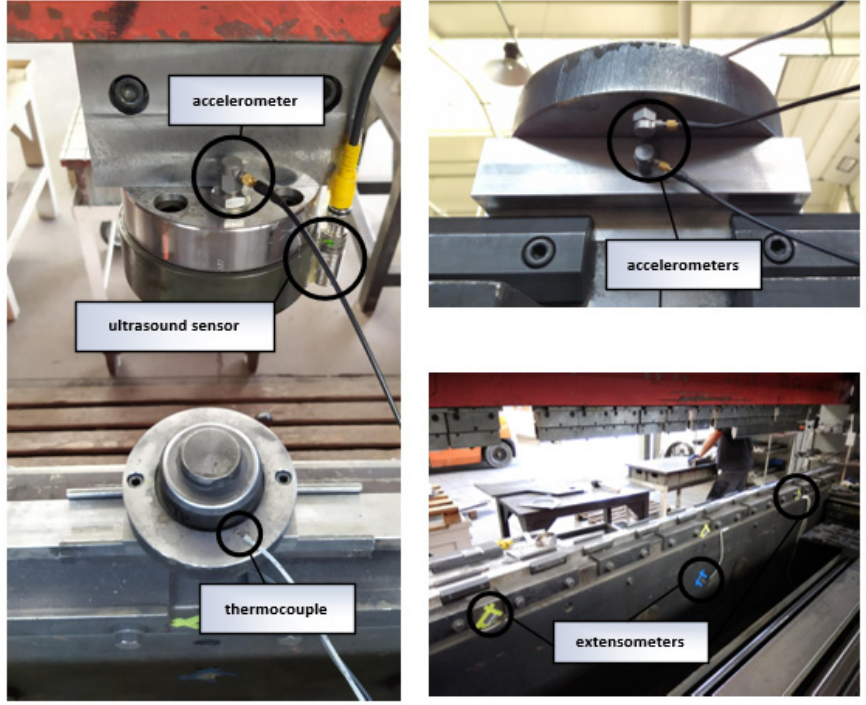
Figure 1. Arrangement of sensors on the machine.